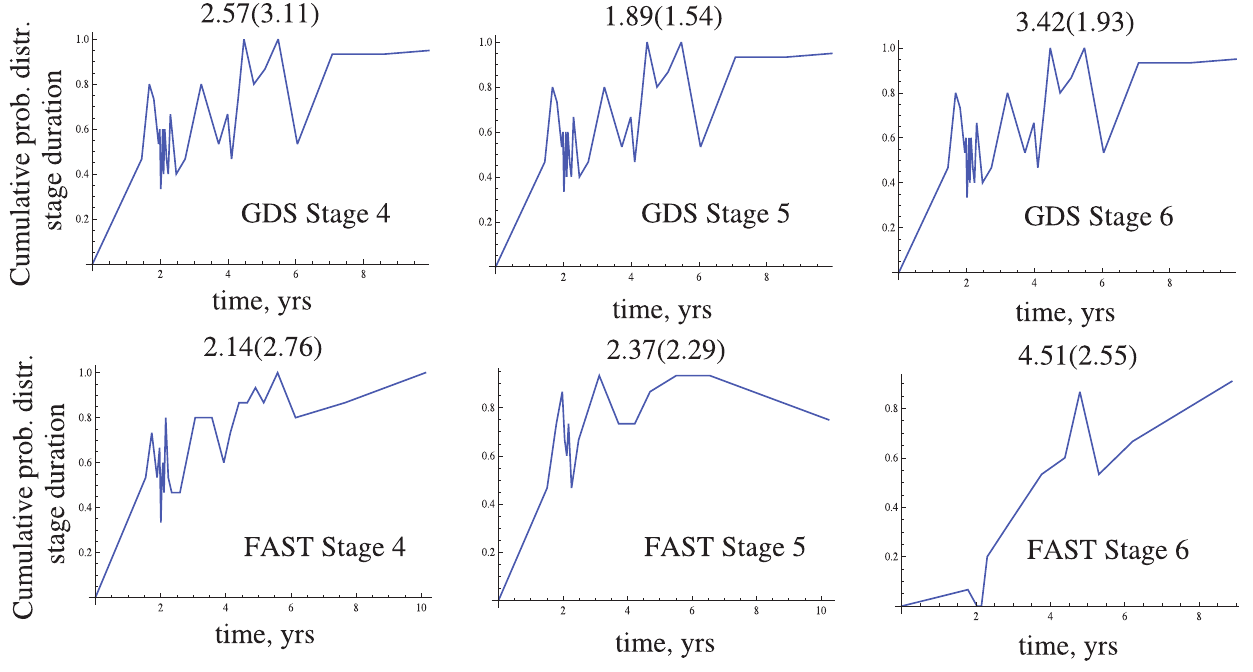
Figure 8. Application of the counting method to estimating the cumulative probability distributions of AD GDS/FAST durations for stages 4, 5, and 6 from an AD dataset [ 25 ] . The parameter ~ tt ~ 0 : 3 yrs was used. The mean and the standard deviation estimated by this method are given on top of each figure.